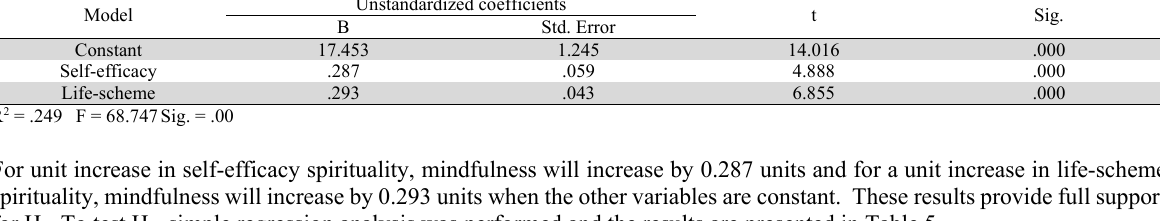
Relationship between Workplace Spirituality and Mindfulness Model